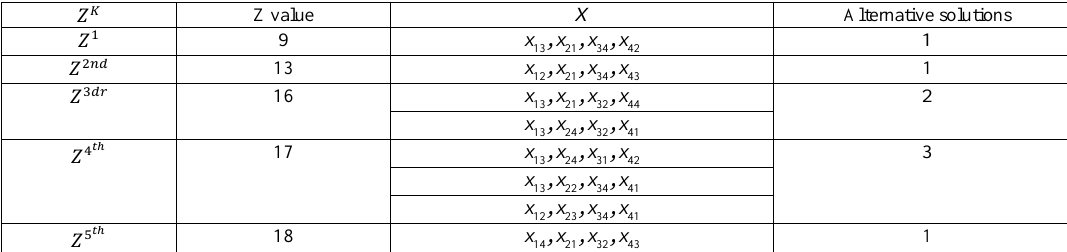
Table 3. 𝑍 5 𝑡ℎ best assignment solution for illustrative